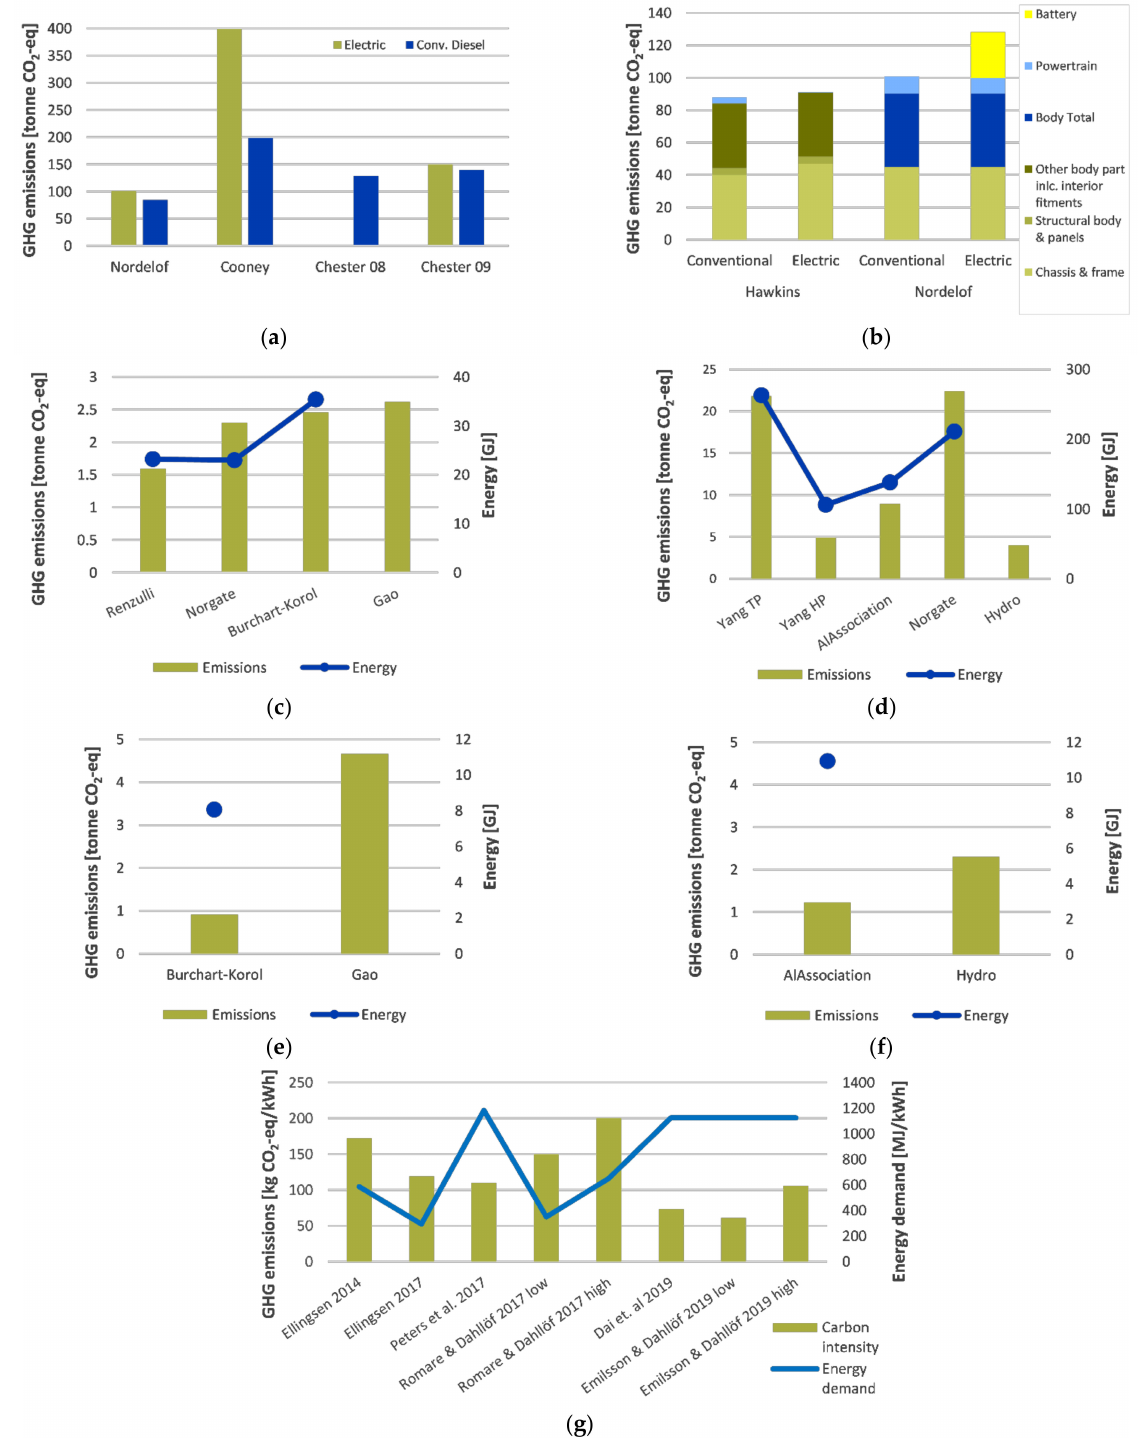
Figure 2. ( a ), total bus production emissions of electric and conventional diesel buses from four LCA studies [50,76–78]; ( b ), estimated bus component production emissions from Hawkins et al. [49] compared to component emissions from Nordelöf et al. [50]; ( c ), GHG emissions and energy consumption per tonne of steel from four LCA studies for primary steel production [79–82]; ( d ), GHG emissions and energy consumption per tonne of aluminium from four LCA studies for primary aluminium production [68,80,83–85]; ( e ), GHG emissions and energy consumption per tonne of steel from two LCA studies for secondary steel production [81,82]; ( f ), GHG emissions and energy consumption per tonne of aluminium from two sources for secondary aluminium production [68,84]; and, ( g ), carbon intensity and energy demand in battery production from 6 different studies